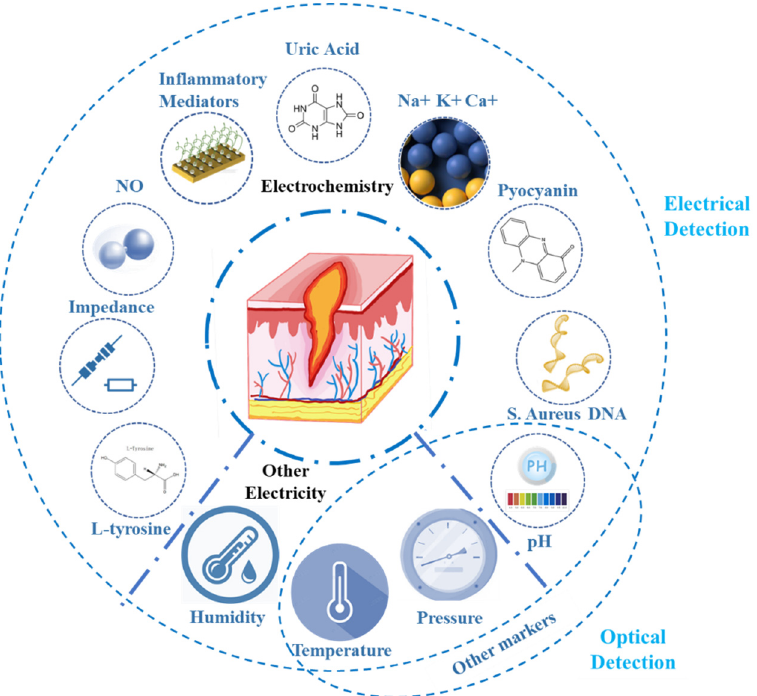
Figure 1. Key markers of wounds detected by flexible wearable sensors based on electrical and optical principles involved in this paper. Among them, electrochemical sensors are widely used for quantitatively detecting a variety of markers.